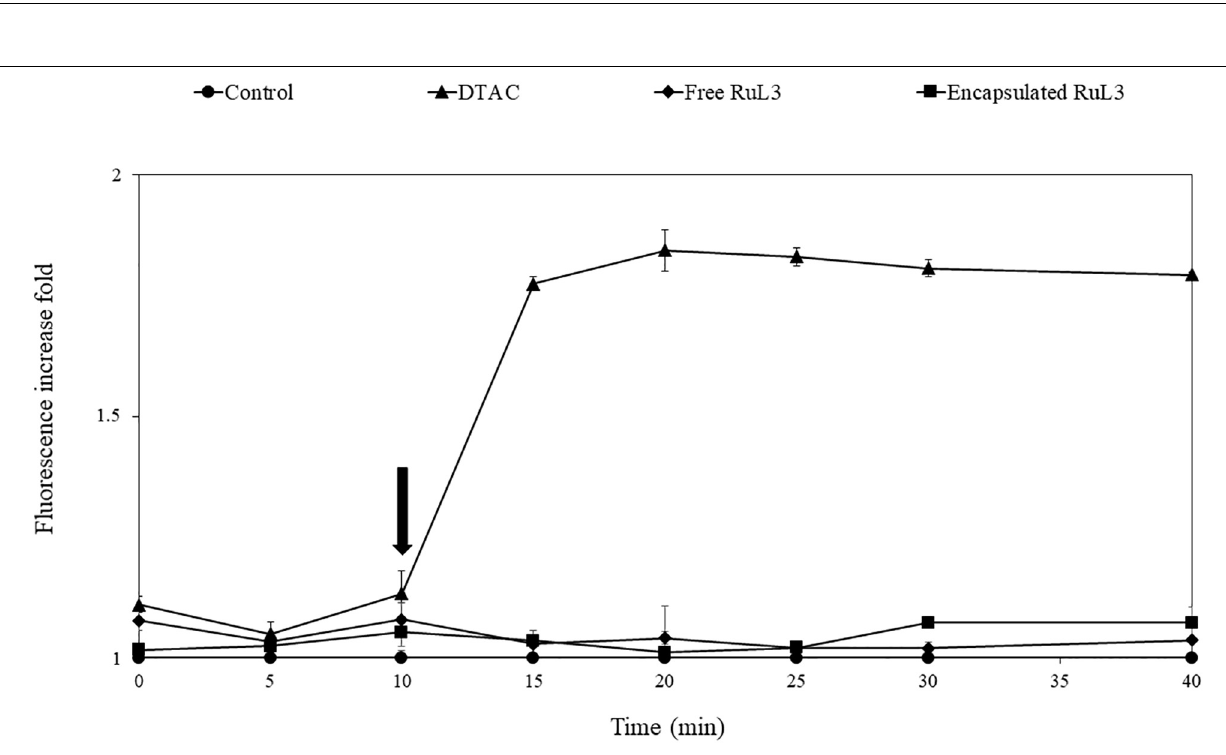
Frontiers in Microbiology |